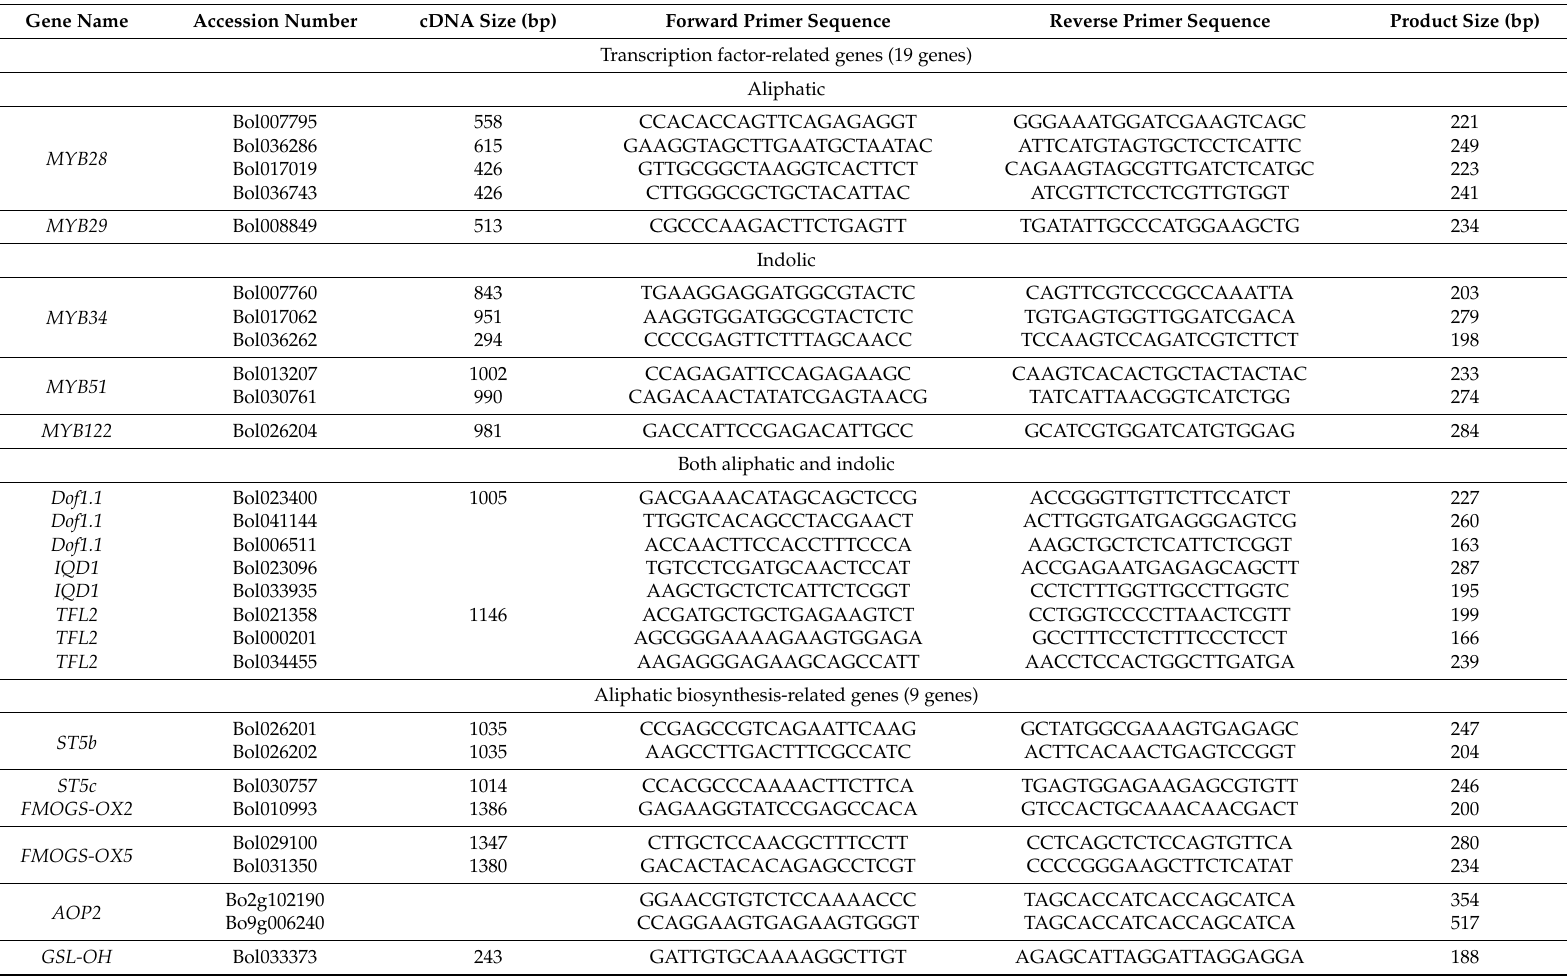
Table 4. Primer sequences of 48 glucosinolate biosynthetic-related genes used for the relative expression analysis of four cabbage inbred lines with morphological variation through